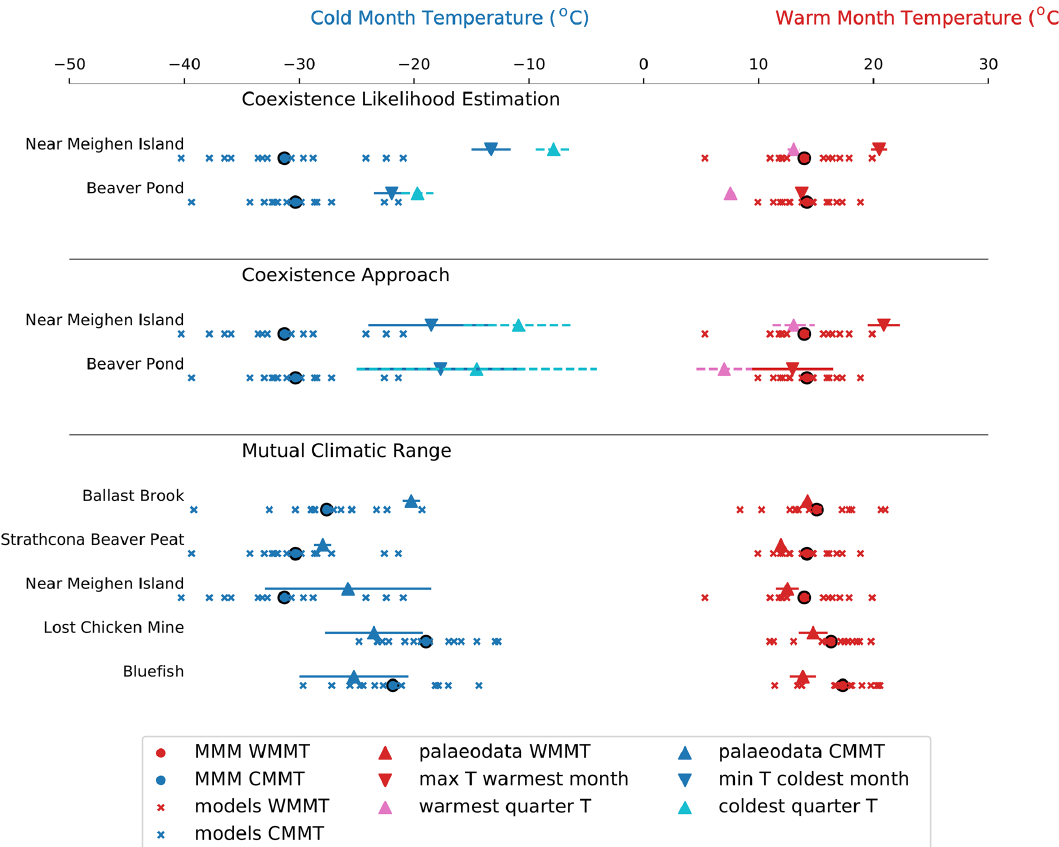
Figure 4. Data–model comparison for the cold month mean temperature (CMMT: blue symbols) and the warm month mean temperature (WMMT: red symbols) for the Pliocene. Triangles show temperatures from beetle assemblage proxy data, which were obtained using various methods with published uncertainties (where available). Model data are shown by circles (MMM) or small crosses (individual models). The location of Meighen Island (80 ◦ N, 99 ◦ W) was an oceanic grid box in most models, and hence Meighen Island data have been compared to a nearby land grid box. Additional metadata for this figure are in Table